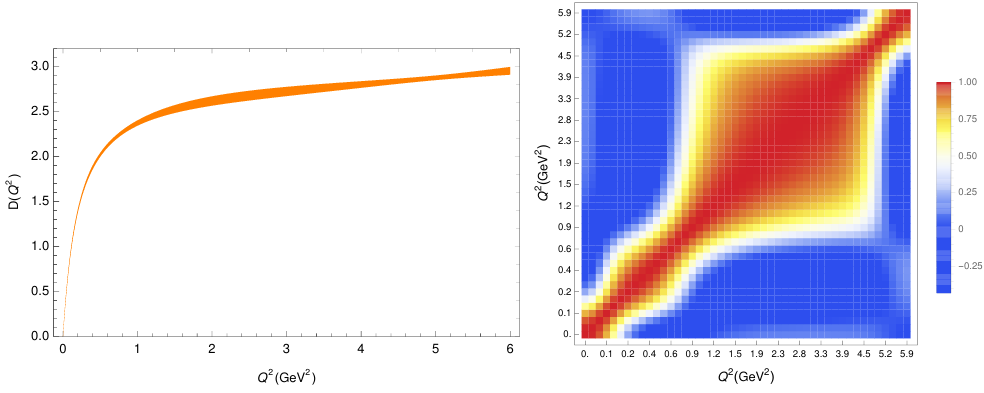
Figure 14 . Adler function obtained from the lattice results of ref. [14] (left) together with its correlation matrix